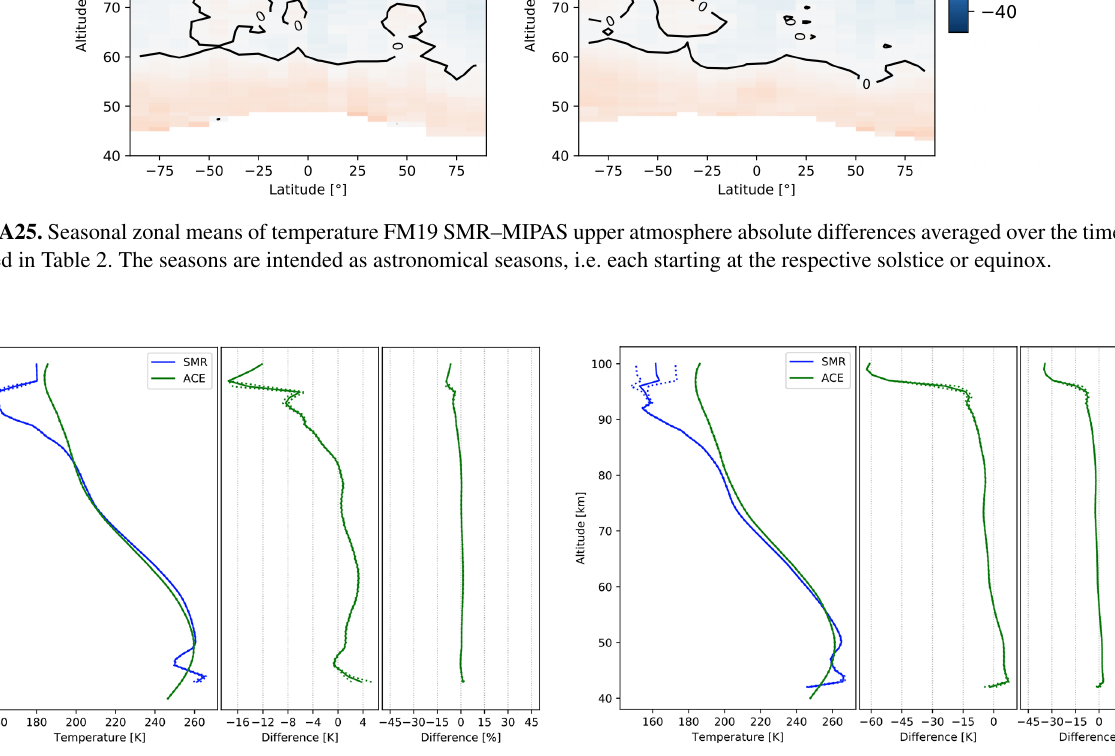
Atmos. Meas. Tech., 14, 5823–5857,